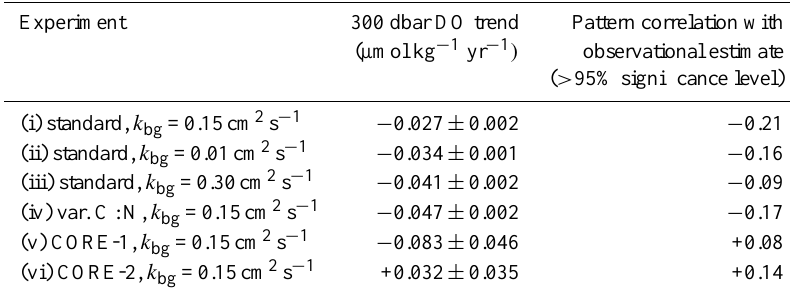
Table 1. Mean trend and standard deviation in dissolved oxygen and pattern correlation with observational estimate (wherever exceeding the 95% threshold) simulated by the various model configurations. Standard model configurations (i) to (iii) employ climatological seasonally cycling monthly winds and Redfield C:N stoichiometry. Only configuration (iv) employs variable C:N stoichiometry. Model experiments (v) and (vi) use Co-ordinated Ocean-ice Reference Experiments (CORE) monthly wind stress fields for the period 1958–2007 with two different spin-up wind fields prior to 1958 (see